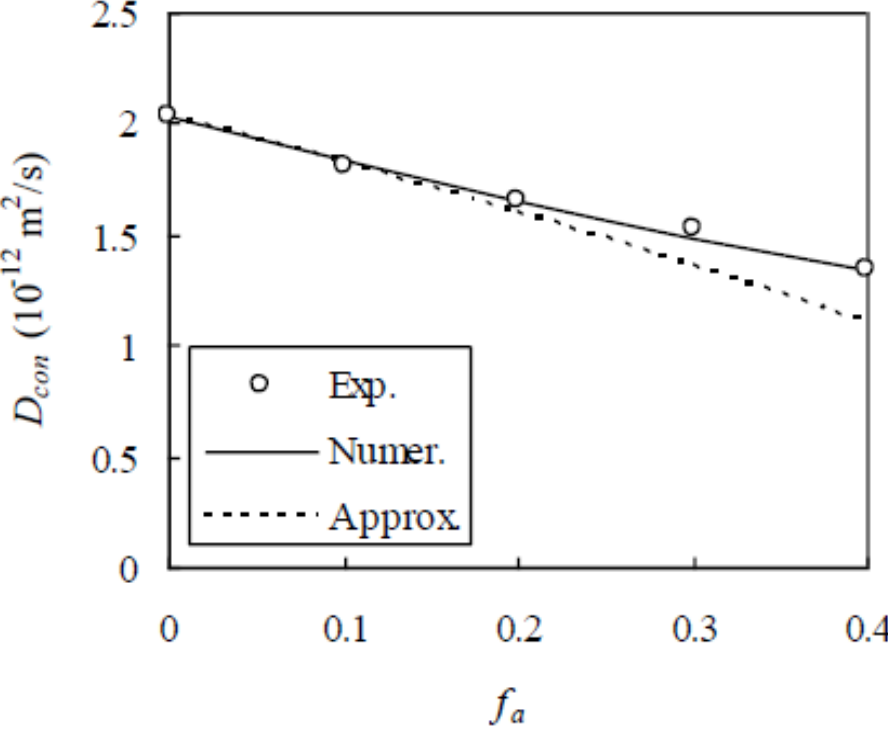
Figure 16. Comparison of numerical method with experimental results of Yang and Su [8] and approximate analytical solution of Shafikhani and Chidiac [38].